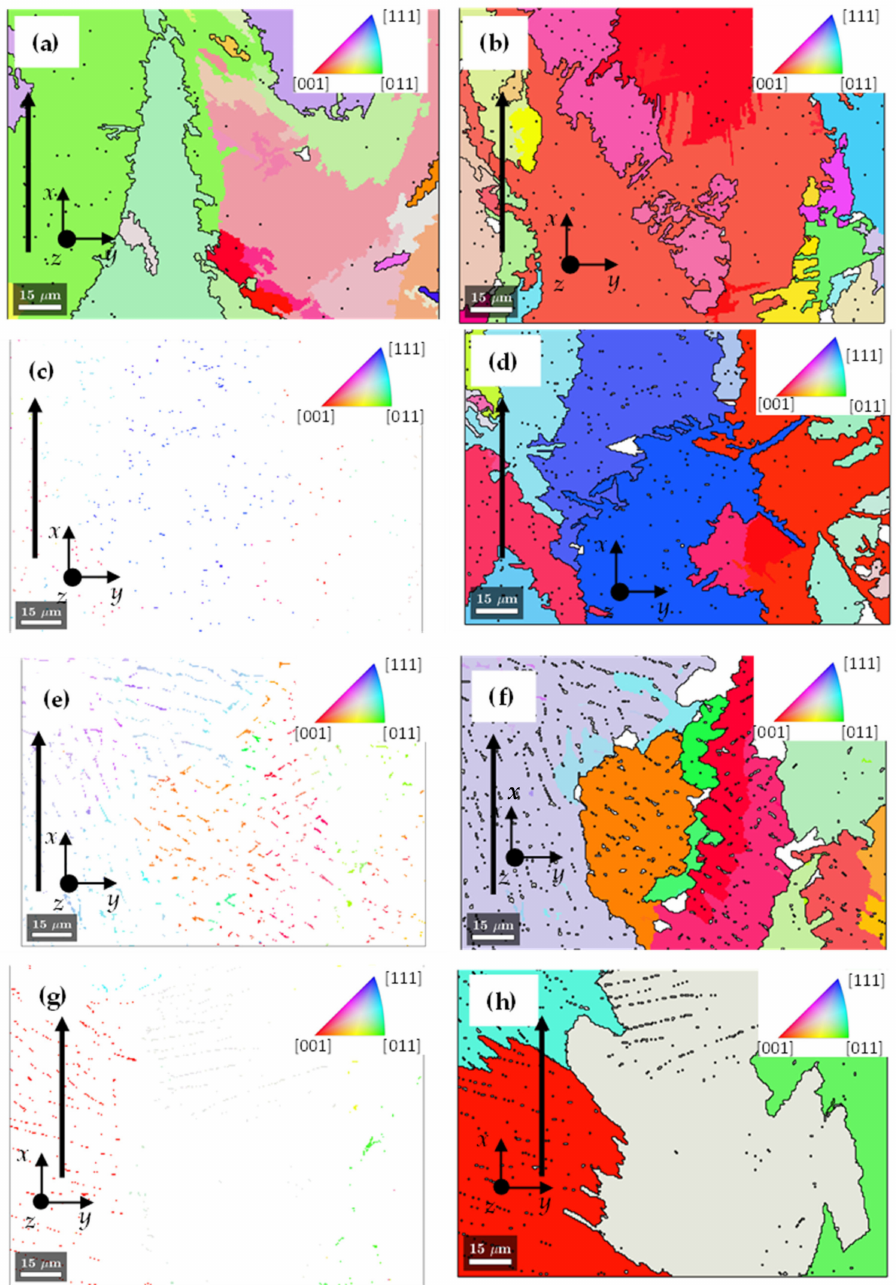
Figure 5. Orientation distribution of reconstructed prior β -grains ( a , b , d , f , h ) and retained β -grains ( c , e , g ) in ( a ) samples A, ( b ) samples B, ( c , d ) samples C, ( e , f ) samples D, and ( g , h ) samples E. The black arrows in the micrographs indicate the build